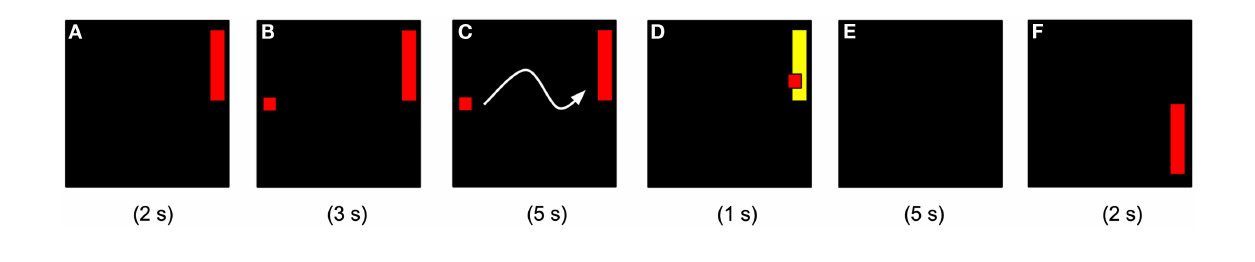
comparison against the average of the last three trials of each type (six trials total); (D) if hit, the target changes to yellow for 1s; if missed, the target remains red; (E) inter-trial interval of 5s; (F) a new trial